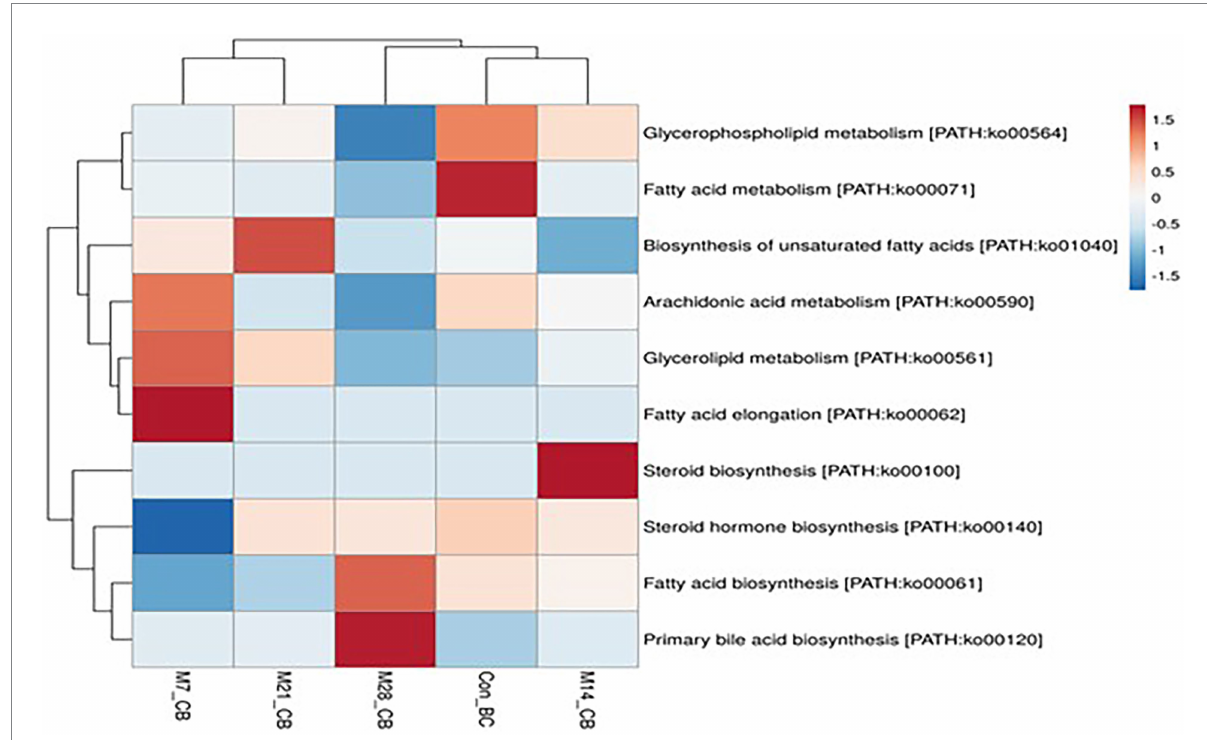
FIGURE 5 The heatmap showing relative abundance of pathways involved in lipid metabolism in the caecum digesta samples from broiler chickens fed with diets containing different levels of marama bean meal. The X -axis shows the treatment groups [Treatment groups: 0% (Con_BC); 7% (M7_BC); 14% (M14_BC); 21% (M21_BC); 28% (M28_BC) inclusion levels] while Y -axis represents metabolism pathways. The scale bar shows the colour saturation gradient dependent on the relative abundance microbial pathways. The colour intensity in each panel reflects relative abundances used for analysis (blue: low, white: medium, red: